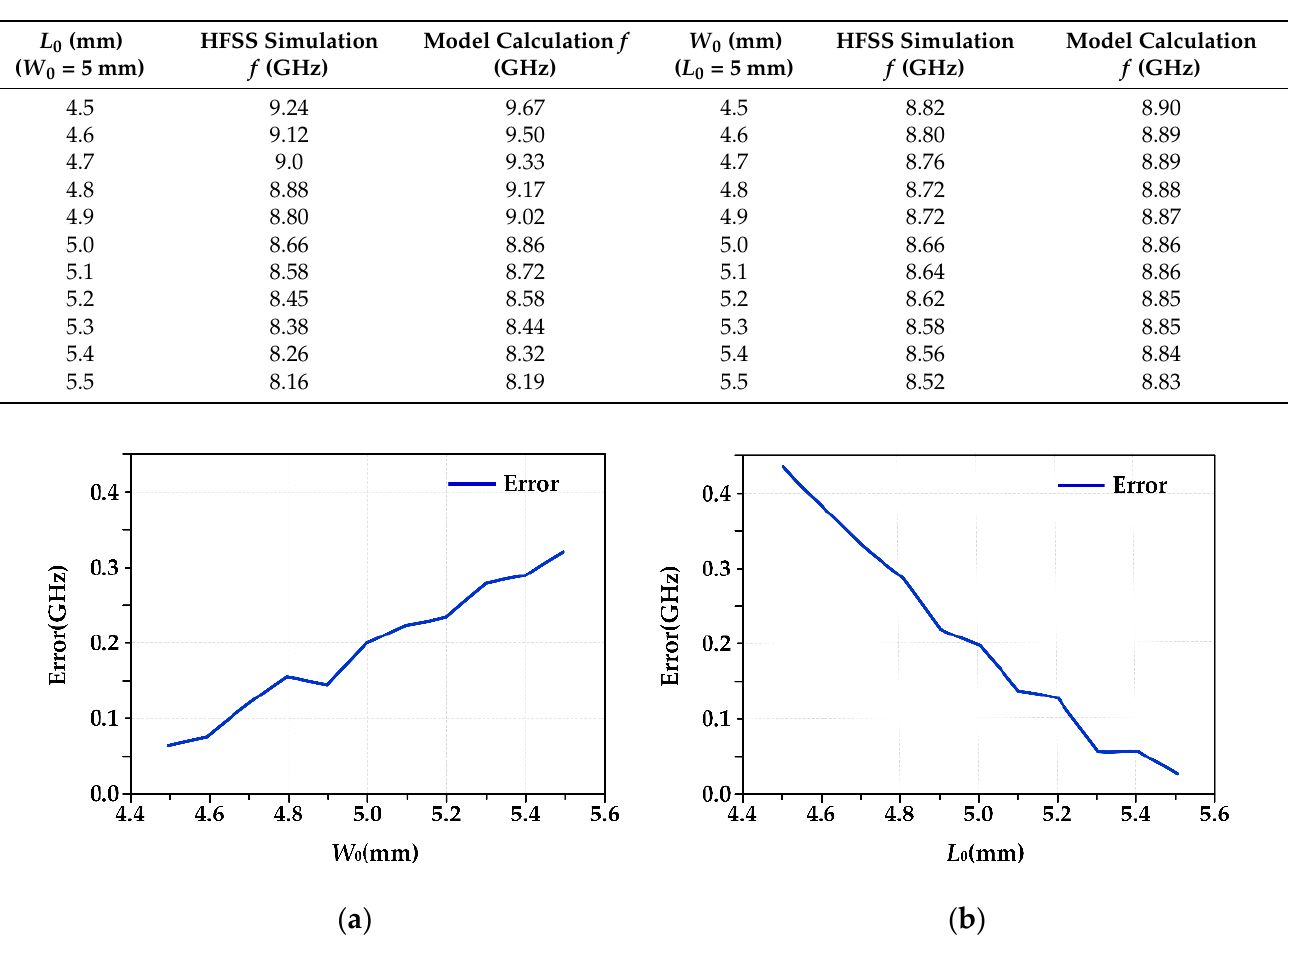
Figure 12. ( a ) Frequency calculation error ( W 0 parameter change); ( b ) frequency calculation error ( L 0 parameter change).